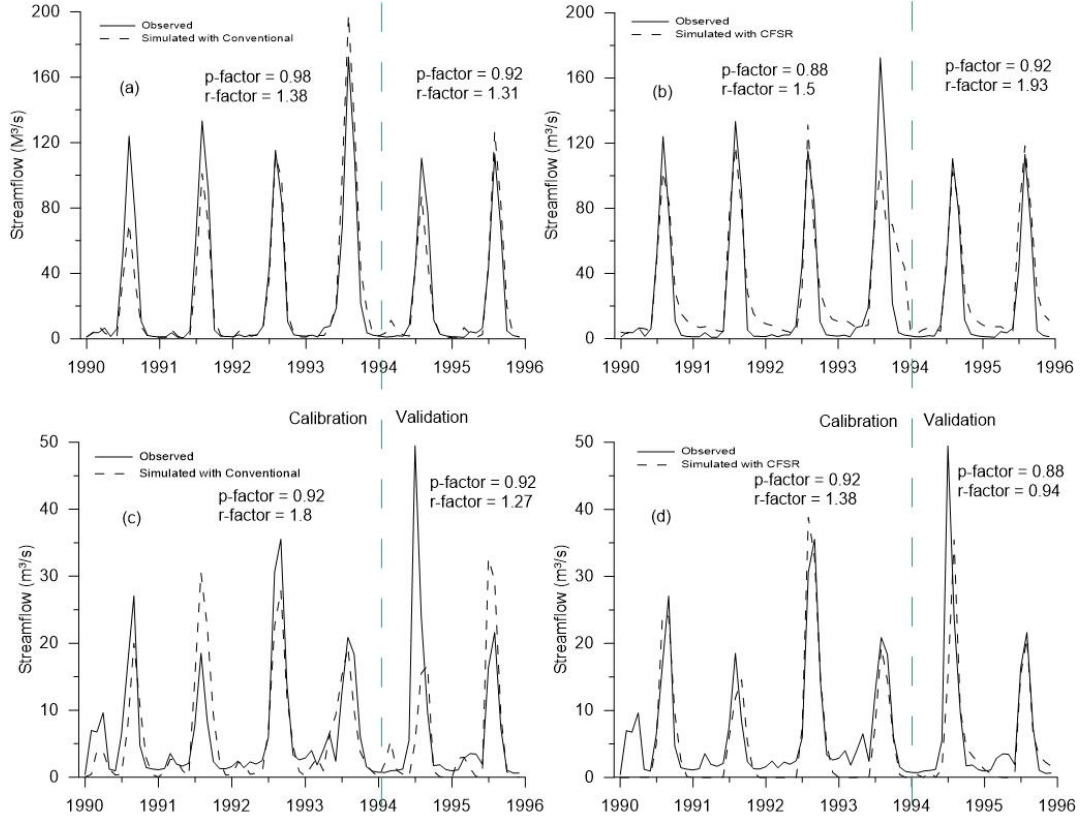
Figure 8. Observed and simulated streamflow at sub-basin outlets ( a ) using conventional weather data and ( b ) CFSR global weather data at Melka Kunture, and ( c ) sing conventional weather data and ( d ) CFSR global weather data at Keleta.